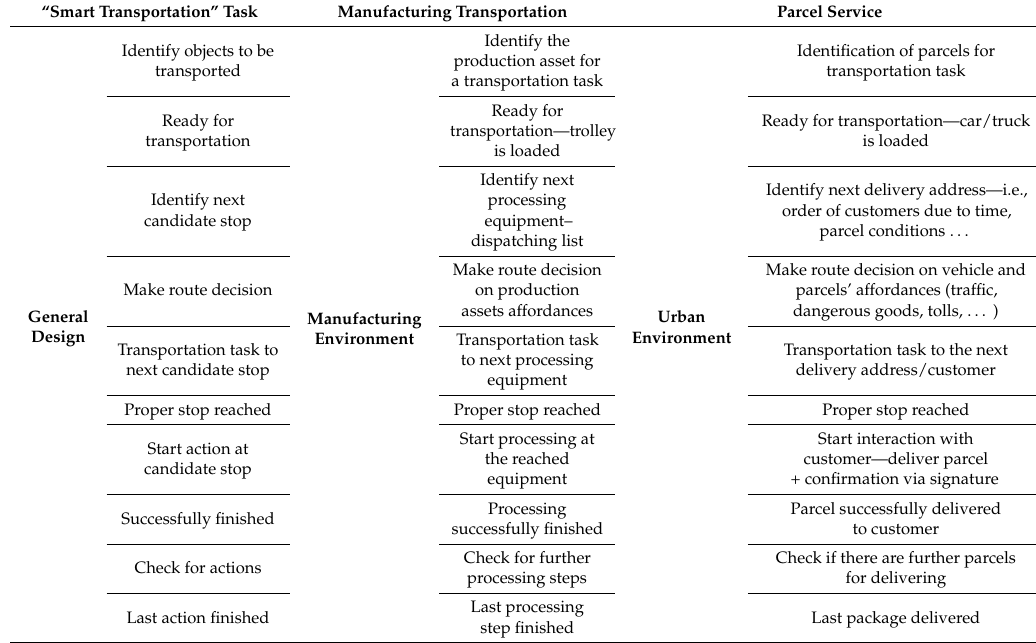
Table 1. Comparison of the defined general tasks and specialized tasks (manufacturing versus urban). “Smart Transportation”